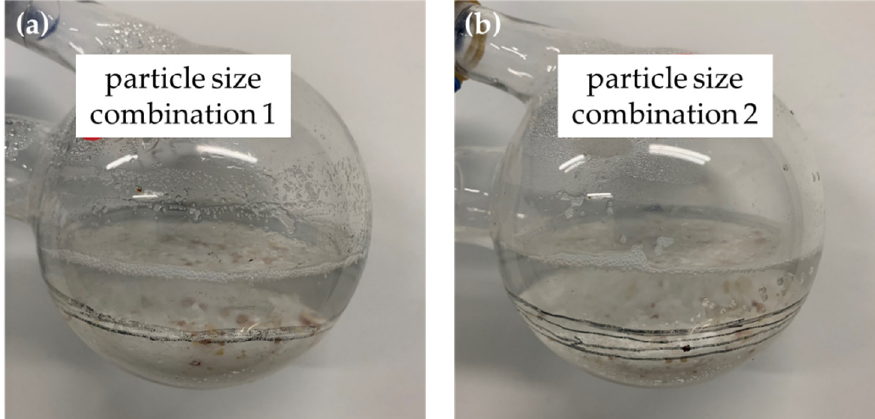
Figure 9. Experimental diagram of particle size dynamic shrinkage. ( a ) The experimental diagram of particle size combination 1, ( b ) the experimental diagram of particle size combination 2.